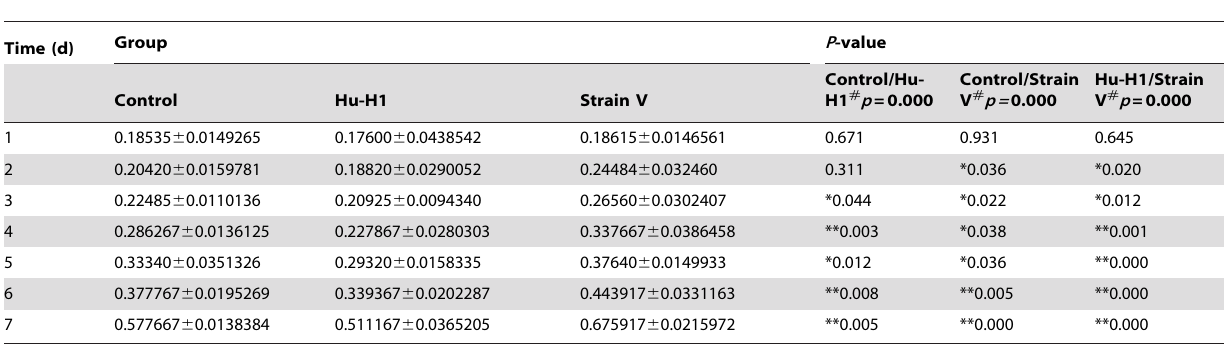
Table 1. Optical densities of Hu-H1, Strain V, and control cells (mean 6 s, n